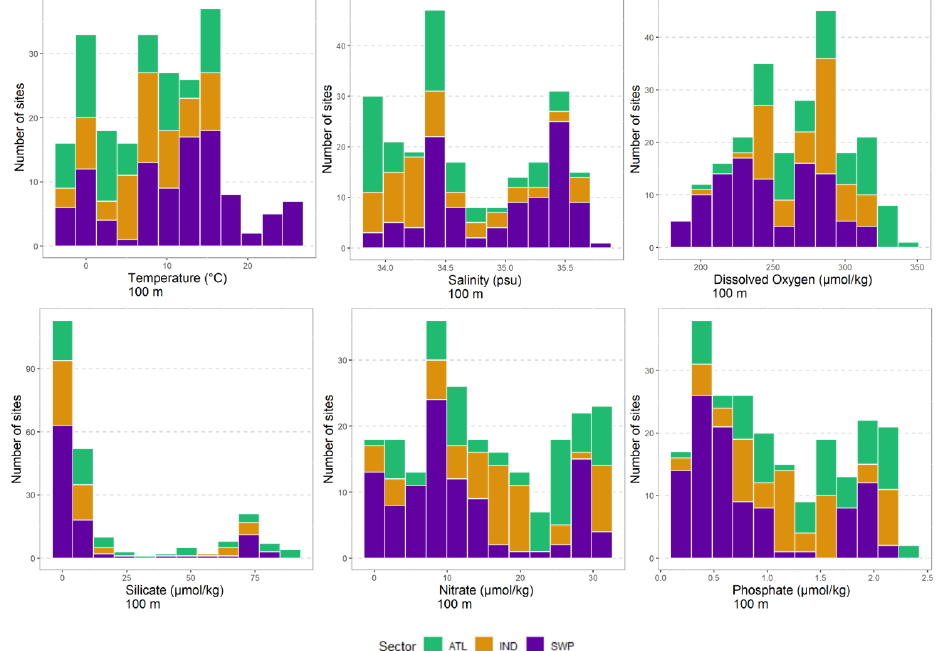
Figure 3. Distribution of sites across observed environmental variables at 100m water depth (Locarnini et al., 2018; Garcia et al., 2019a, b; Zweng et al., 2019) identified by sector – Atlantic Ocean sector (ATL, green), Indian Ocean sector (IND, orange), and southwest Pacific sector (SWP,